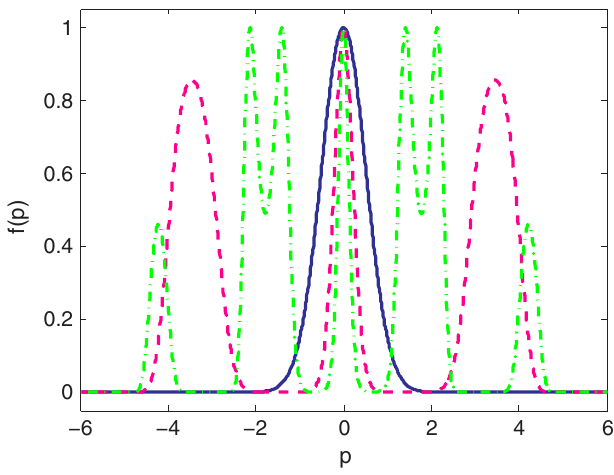
FIG. 5. (Color) Energy distribution at z ¼ 0 for various values of R 56 . Solid blue curve: R 56 (cid:1) E=E ¼ (cid:6)= 4 ; dashed magenta line: (cid:1) E=E ¼ (cid:6) ; and dash-dotted green line: R R 56